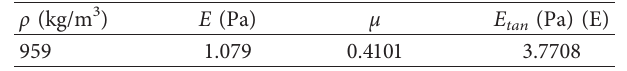
Table 3: Parameters of the PE pipe.